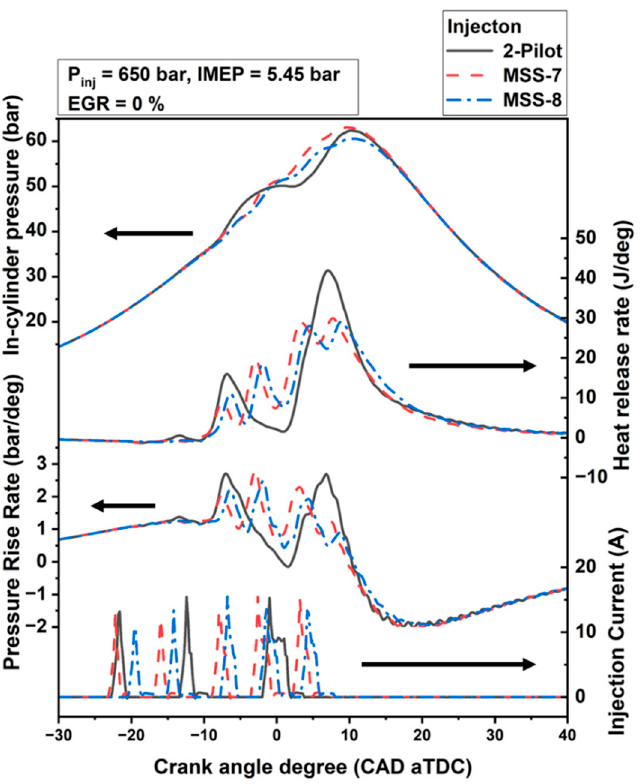
Figure 6. In-cylinder pressure, heat release rate, pressure rise rate, and injection current results for two-pilot injection strategy and two MSS injection strategies without EGR.